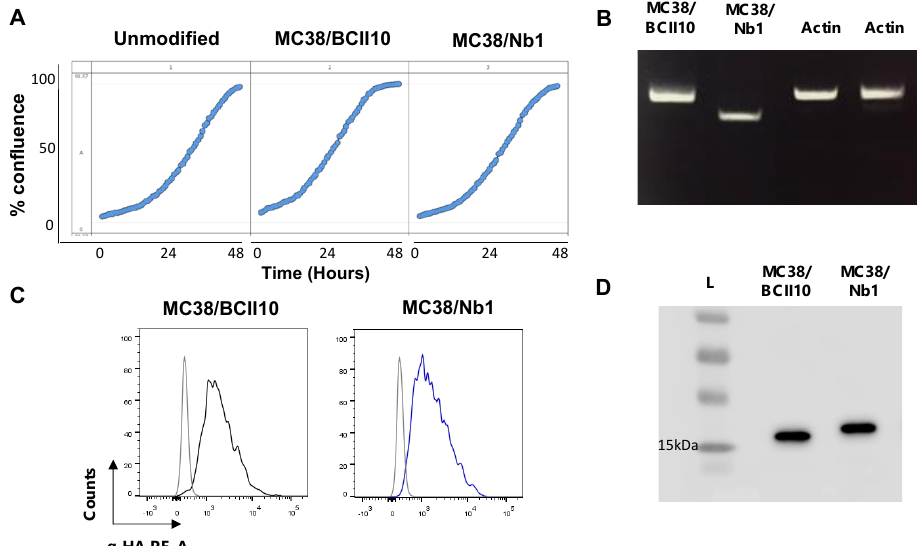
Figure 4. MC38/Nb1 and MC38/BCII10 show similar characteristics to unmodified MC38 cells and produce Nbs. ( A ) The graphs show the relative confluence for the growth of unmodified MC38 cells or MC38 cells lentivirally engineered to express BCII10 or Nb1, measured at several time points over a period of 2 days using the Incucyte instrument. ( B ) The image shows the result of the RT-PCR performed to detect expression of BCII10 or Nb1 mRNA in modified MC38 cells. ( C ) The histogram overlays show the intracellular staining of hemagglutinin (HA)-tagged Nbs in MC38/BCII10 (black line) or MC38/Nb1 (blue line). Cells stained with isotype-matched antibodies (gray histogram) served as a negative control. ( D ) Western blot was performed on supernatants collected from MC38/BCII10 or MC38/Nb1 to confirm secretion of the Nbs. The results shown in ( A – D ) are representative of three independent experiments ( n = 3). Full western blot images of Figure 4B,D are available in the Supplementary Material (Figures S6 and S7).